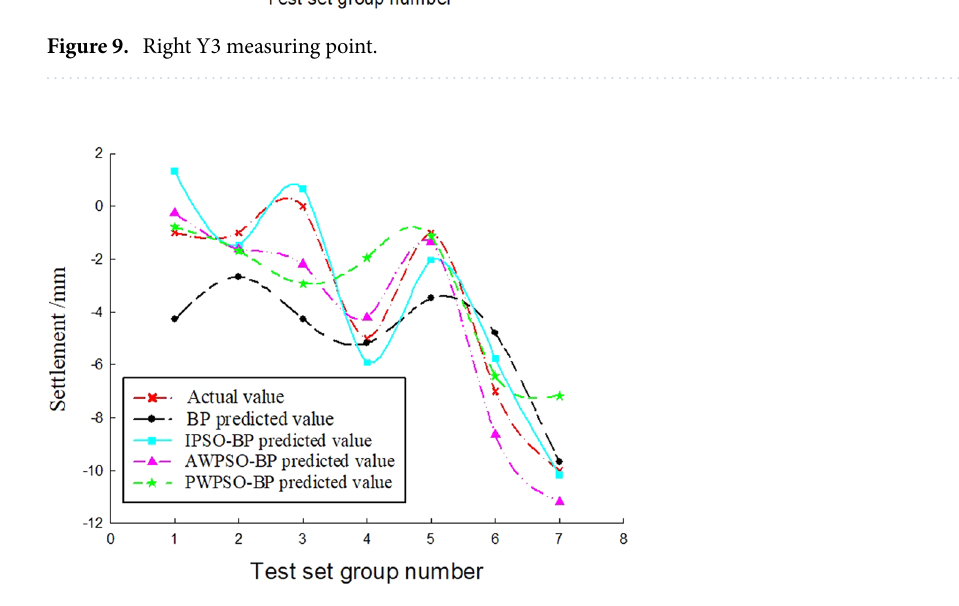
Figure 10. Left Z-1 measuring